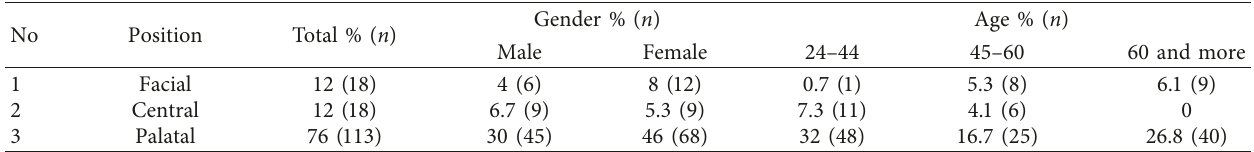
Table 2: CS localization regarding to facial-palatal